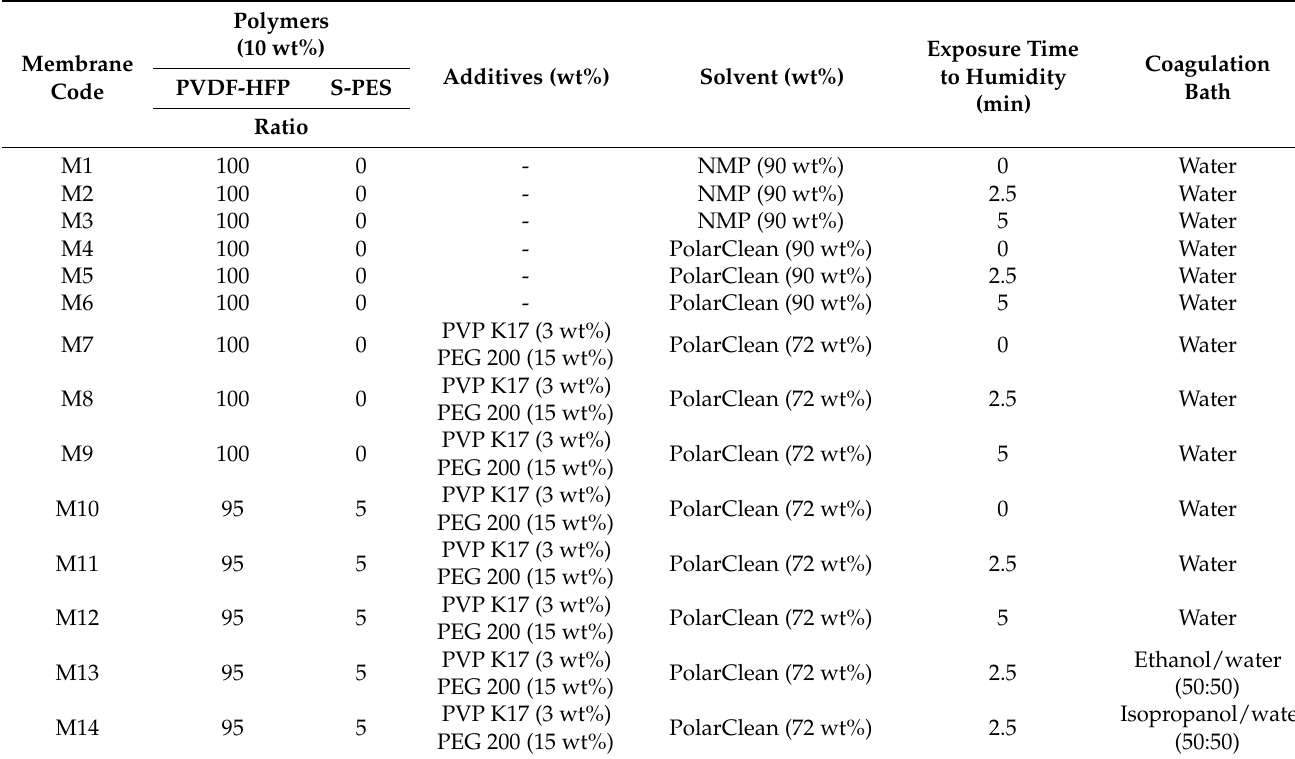
Table 2. Dope solutions’ compositions and investigated conditions to produce PVDF-HFP membranes.